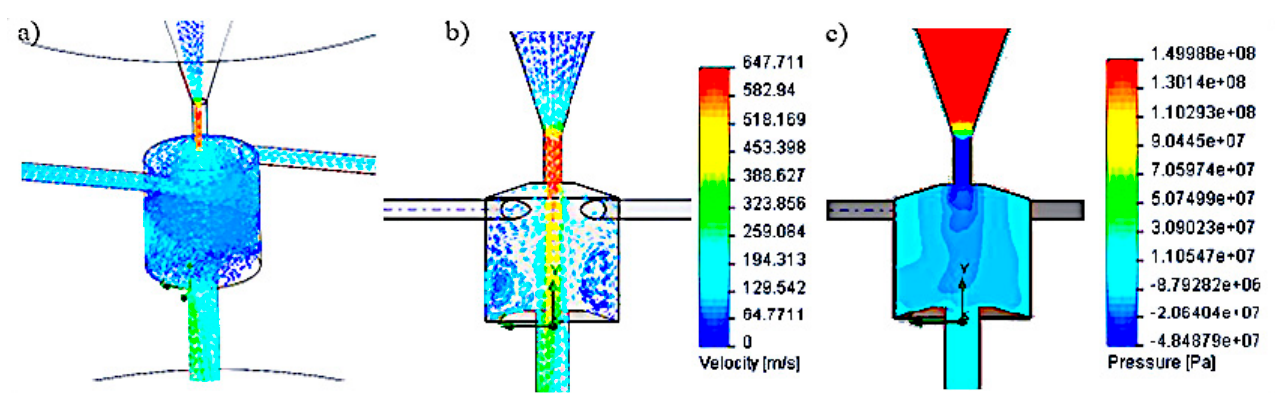
Figure 4. Distribution test results: ( a , b ) speed and ( c ) pressure inside the self-excited pulse head with side openings tangent to the swirl chamber.